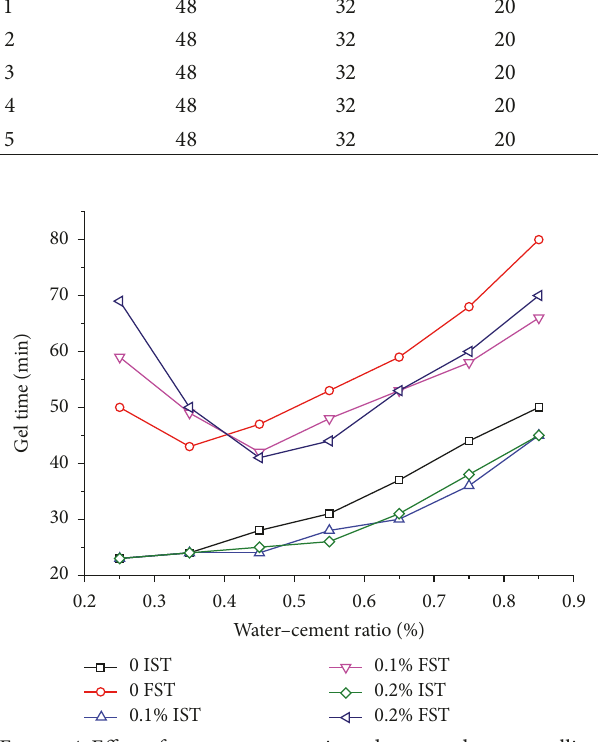
Figure 4: Effect of water–cement ratio and water reducer on gelling